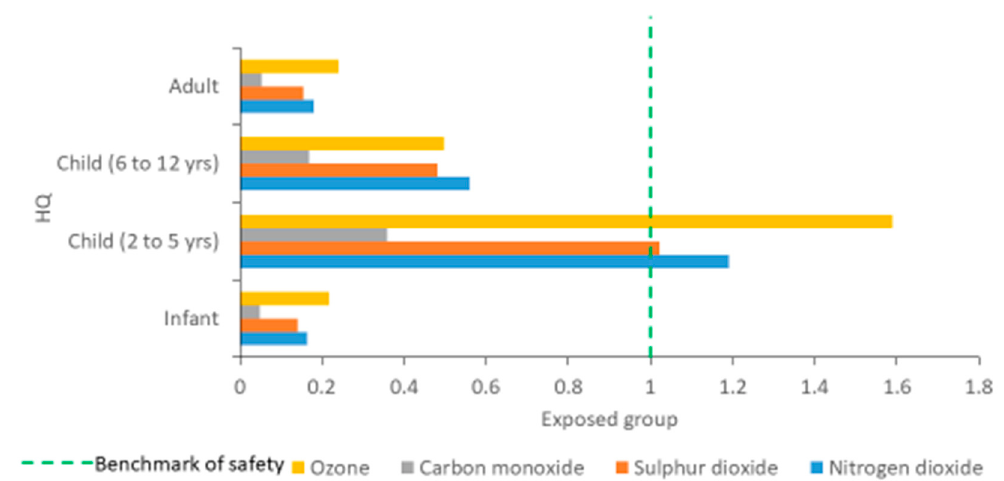
Figure 6. Non-carcinogenic risks of NO 2 , SO 2, CO, and O 3.